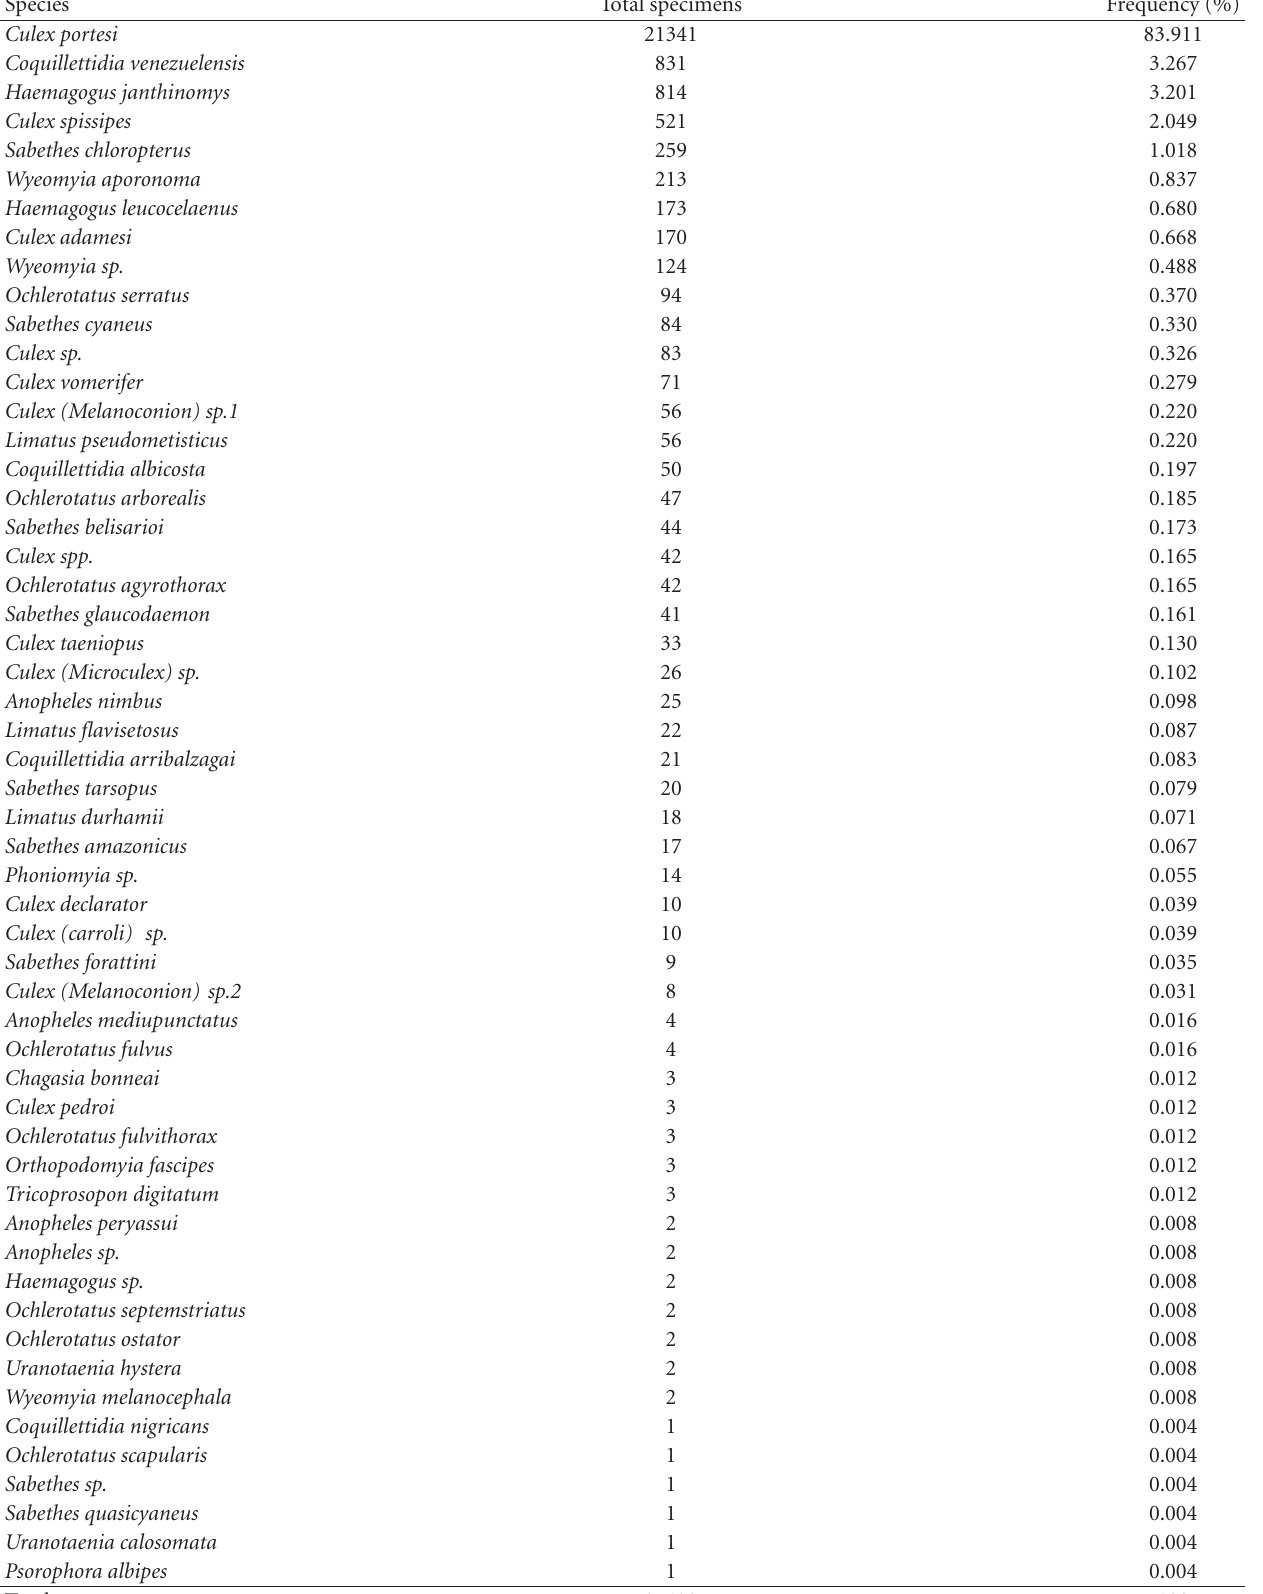
Table 1: Culicid species collected at the LBA tower site in Caxiuan˜a, Melgac¸o, Par´a,